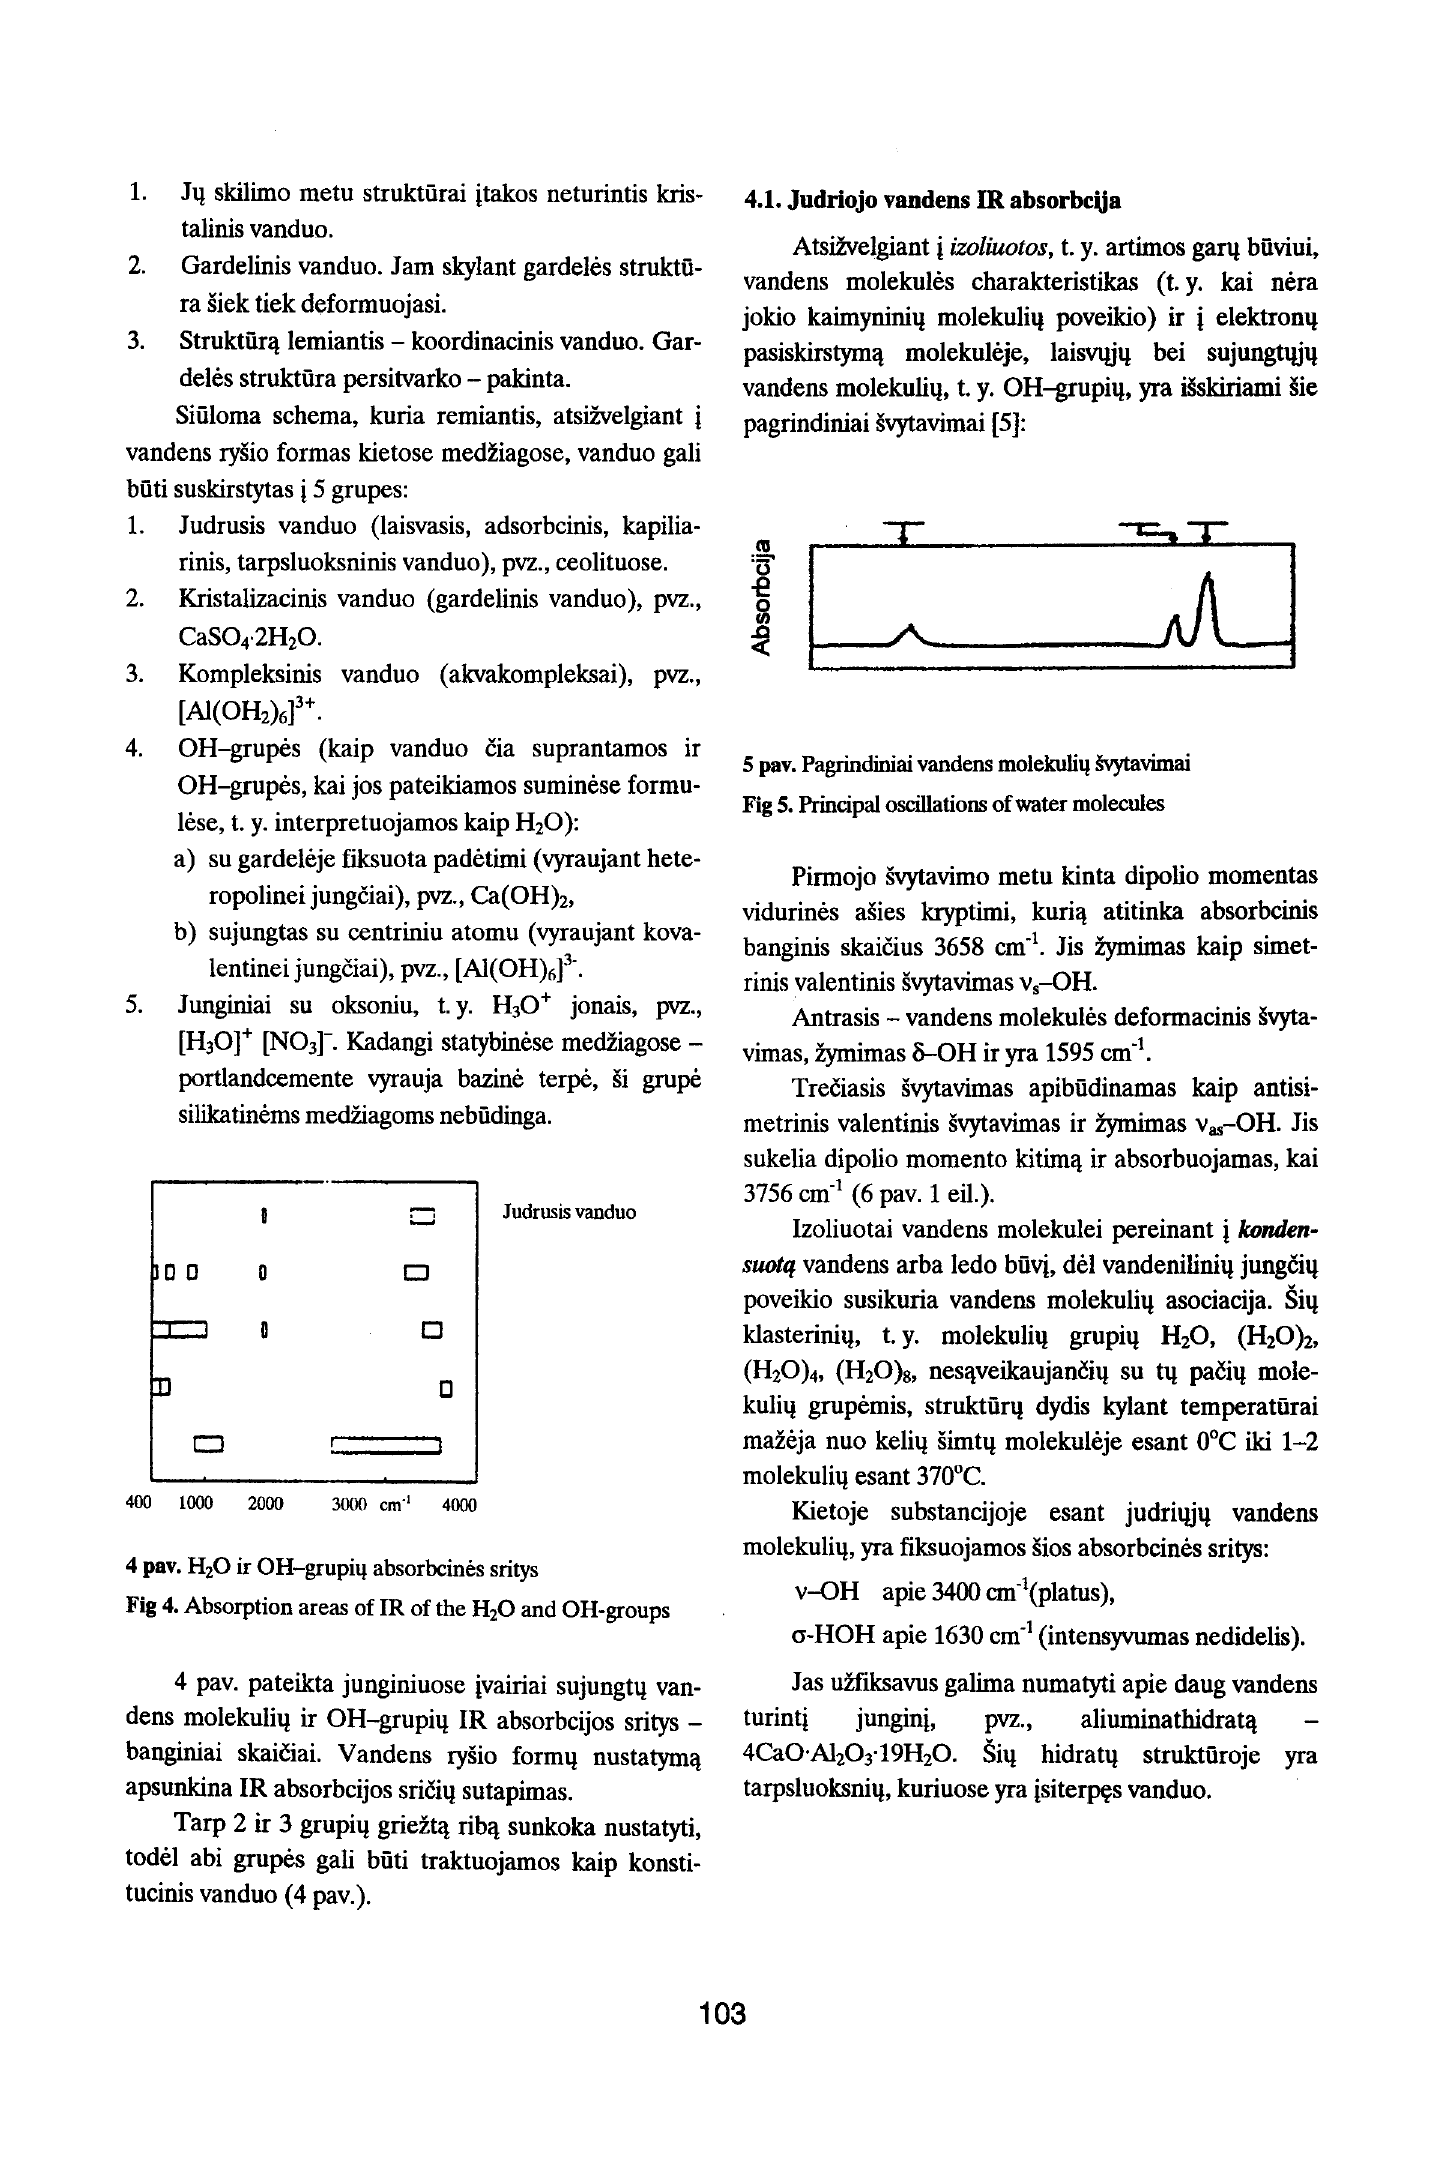
Fig 4. Absorption areas of IR of the H 2 0 and OR-groups 4 pav. pateikta junginiuose ivairiai sujungtq van dens molekuliq ir OH-grupiq IR absorbcijos sritys - banginiai skaiciai. Vandens rysio formq nustatym<l apsunkina IR absorbcijos sriciq sutapimas. todel abi grupes gali biiti traktuojamos kaip konsti tucinis vanduo ( 4 pav. ).